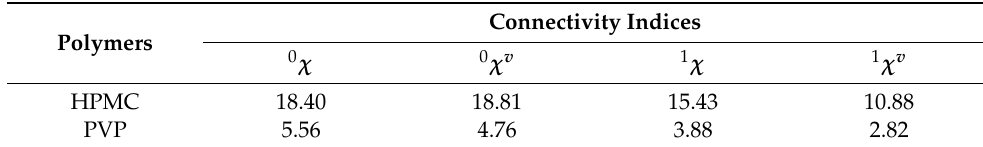
Table 2. Zero-order connectivity indices, 0 χ and 0 χ v , and first-order connectivity indices, 1 χ and 1 χ v for HPMC and PVP.